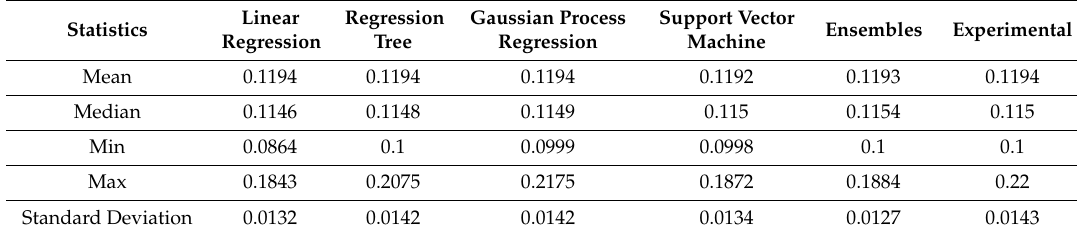
Figure 6. Scatter plots of predicted values versus experimental values of dissolved hydrogen content in liquid aluminum for di ff erent ML models of ( a ) linear regression, ( b ) regression tree, ( c ) GPR, ( d ) SVM, and ( e ) ensemble regression trees. Table 7. Comparison between the statistics of predicted values using di ff erent machine learning models with that of the experimental data of the hydrogen content in the liquid aluminum.